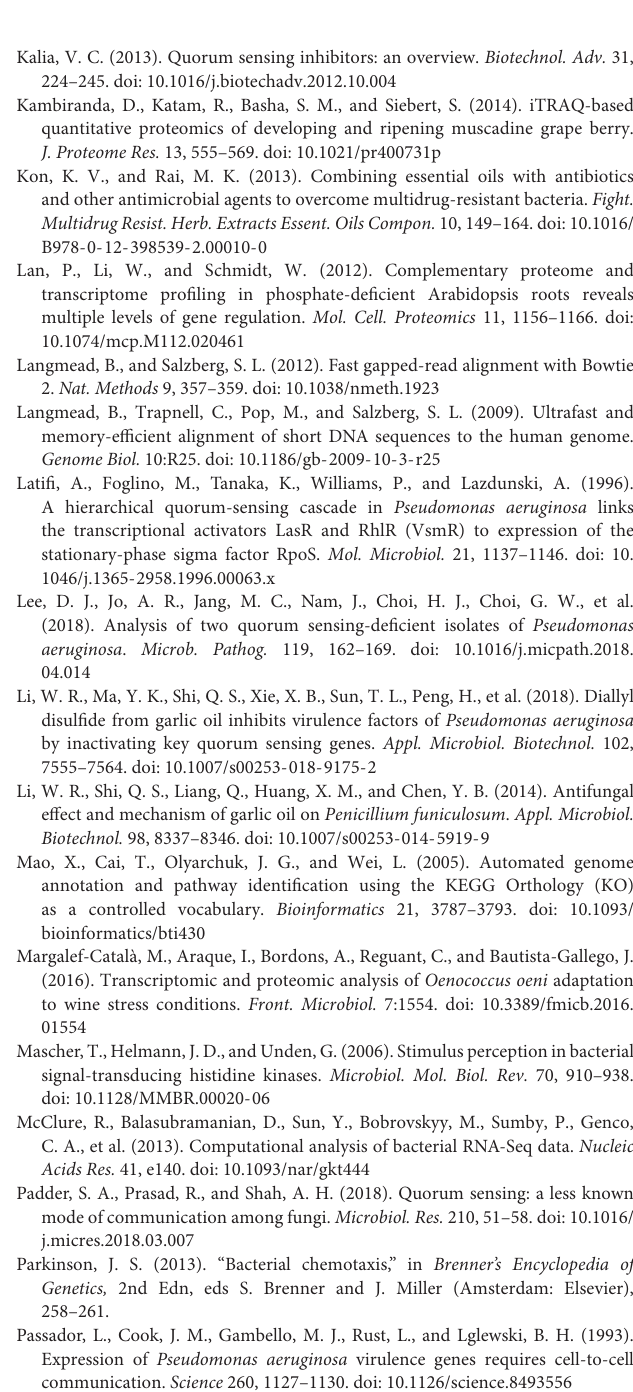
TABLE S7 | The twofold differentially expressed protein data of DADS-treated Pseudomonas aeruginosa PAO1 vs. control groups based on proteome sequencing